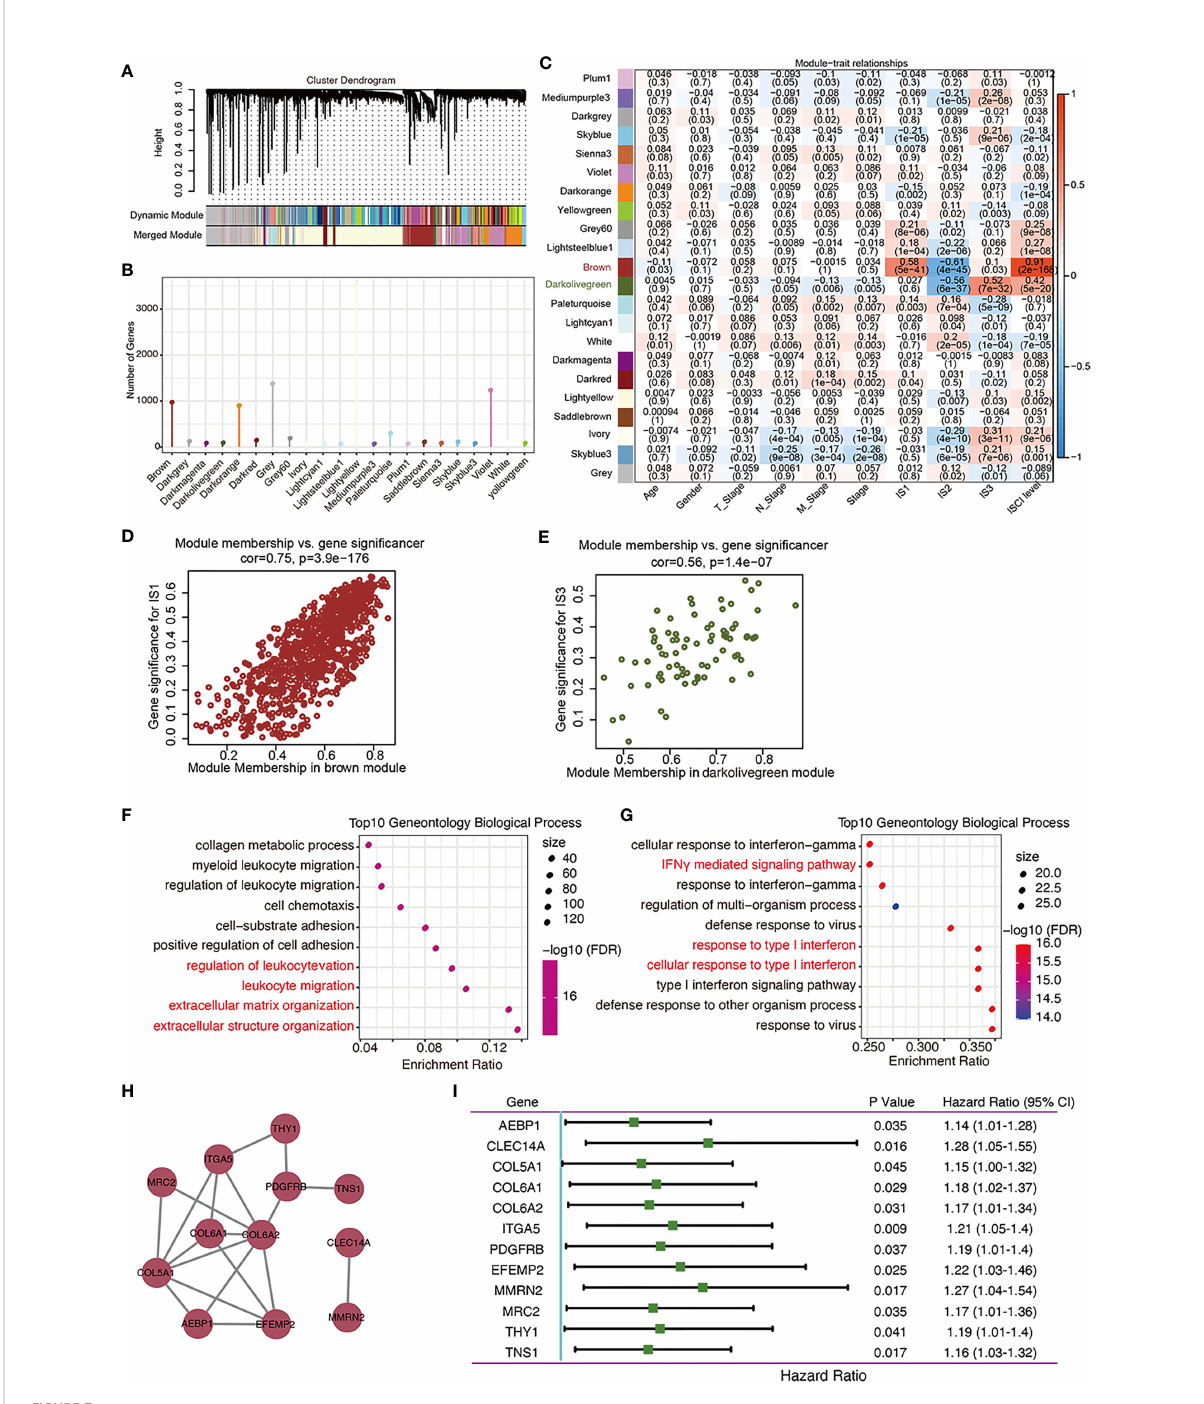
FIGURE 7 Identi fi cation of immune gene co-expression modules of COAD. (A) Dendrogram of all differentially expressed genes clustered based on a dissimilarity measure. ( B ). Gene numbers in each module. (C – E) . Evaluation of the distribution of these 22 modules in each clinicopathological feature and immune subtype (C) . The brown module was positively correlated with IS1 (D) and negatively correlated with IS2, while the darkolivegreen module was negatively correlated with IS2 and positively correlated with IS3 (E) . (F, G). Dot plot showing top 10 gene ontology biological processes in the brown (F) and darkolivegreen (G) module. (H) . Protein – protein interaction network of 12 DFS-related hub genes: AEBP1, CLEC14A, COL5A1, COL6A2, ITGA4, PDGFRB, EFEMP2, MMRN2, MRC2, THY1 , and TNS1 . (I) . Forest plot of the univariate Cox regression analyses for the prognosis value of the indicated 12 genes in TCGA- COAD